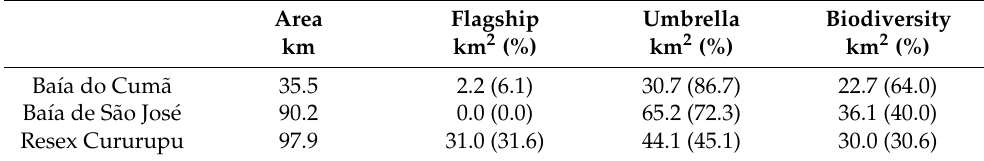
Table 5. Area of each potential conservation zone delineated by conservation strategy.